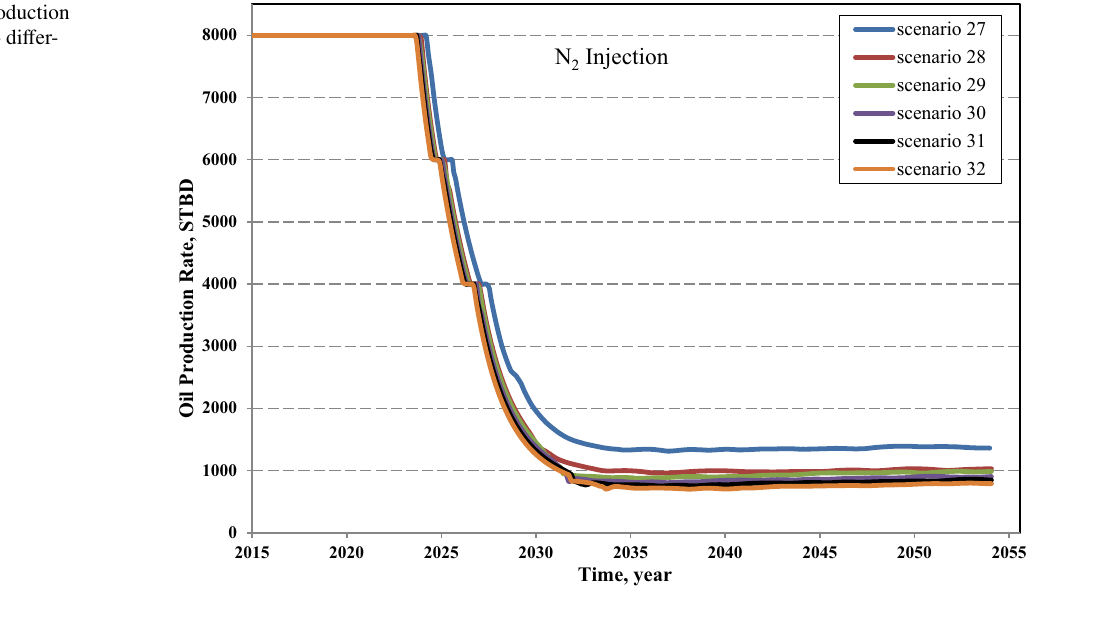
Fig. 12 Reservoir oil production rate for N 2 injection into differ- ent reservoir layers